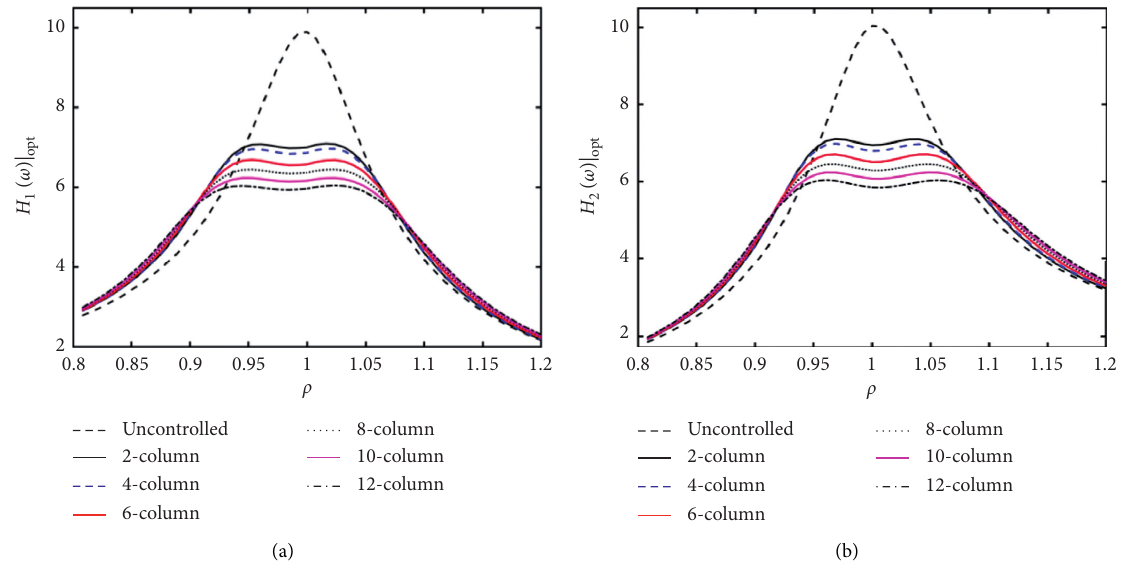
Figure 7: Transfer functions plot of 0.5 b w columns’ diameter TLMCDs with various number of columns: (a) transfer function of dis- placement and (b) transfer function of acceleration.